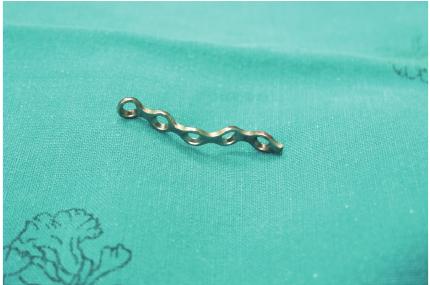
Figure 7: The maxillofacial titanium miniplate can be adjusted in lengthandbentinallthreedimensionstofitthecontouroftheopen- door side of the